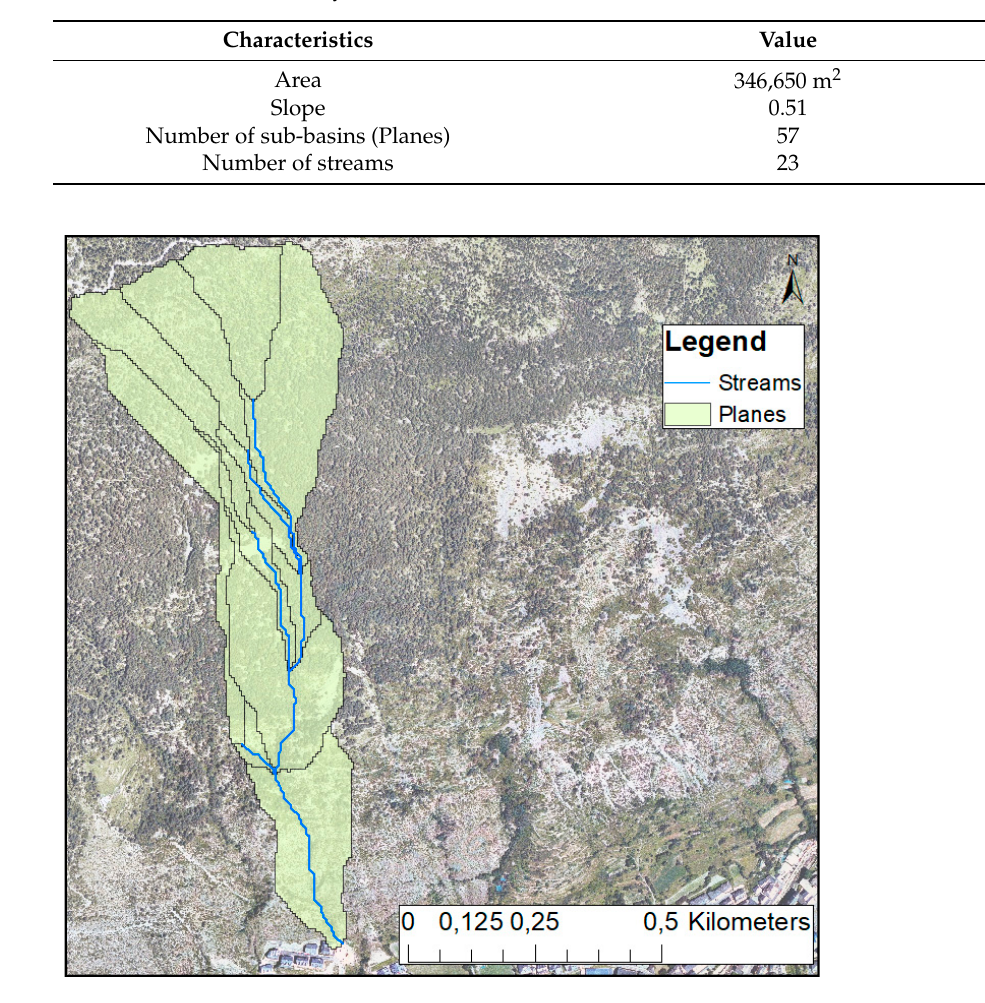
Figure 4. Generated basin with sub-catchments and streams. Table 3. Detail value of study basin [3].